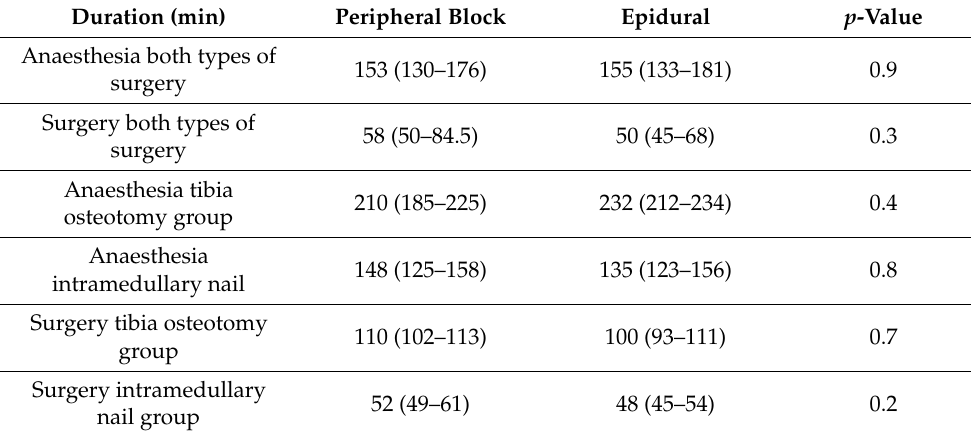
Table 2. Median duration of procedures in sheep undergoing tibia osteotomy or intramedullary tibial nail implantation. No differences could be detected when the durations of the two procedures were